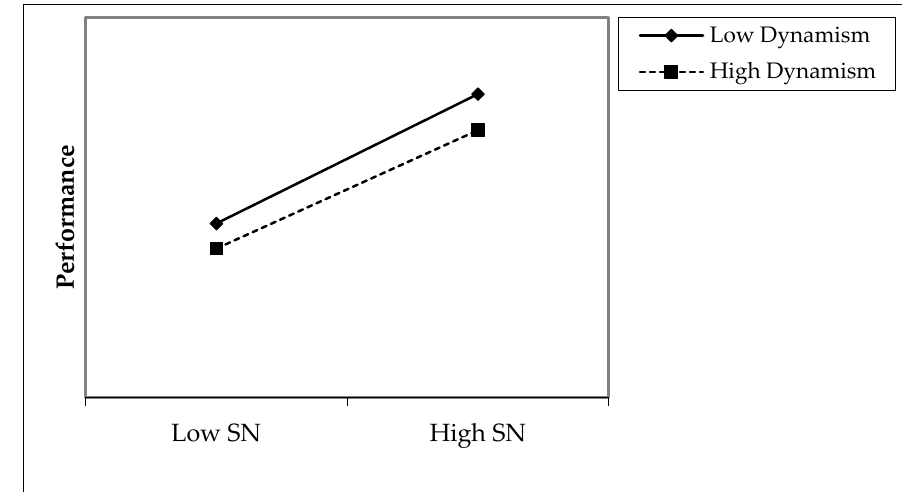
Figure 3. Interaction effect of entrepreneurial orientation and strategic networking.